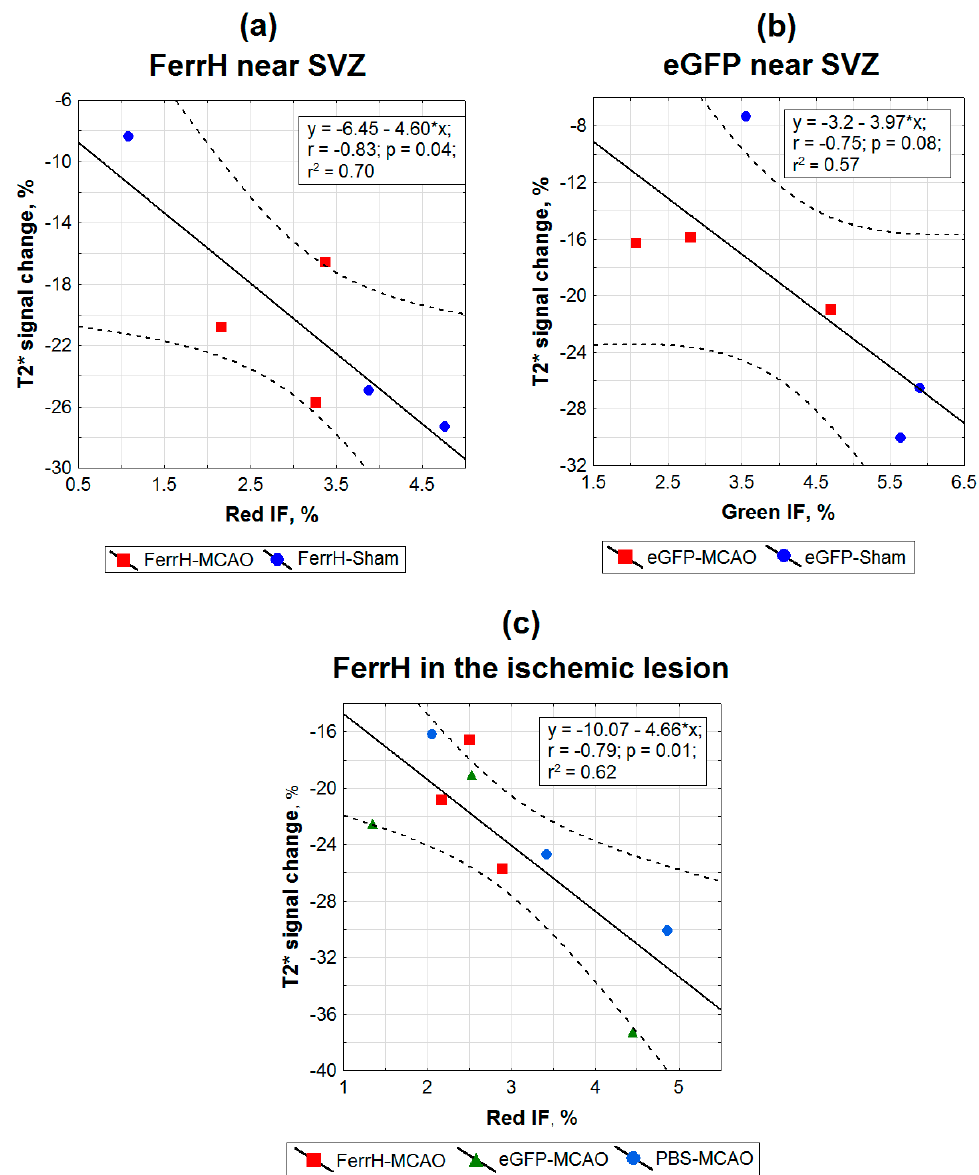
Figure 5. Histological validation of the MRI signal hypointensity areas at day 28 after AAV-pDCX-FerrH, AAV-pDCX-eGFP, or PBS with fluorescent images of eGFP signal, FerrH-, and CD68-stained brain sections. Panels ( a – c ) show linear regression plots of the percentage changes in T2* signal hypointensity relative to the baseline point as in the ischemic lesion relative to the symmetric contralateral anatomical region as a function of ( a ) FerrH IF in the zone near the SVZ, ( b ) eGFP IF in the zone near the SVZ, and ( c ) FerrH IF in the ischemic lesion. Points represent color-coded individual data for the animals from di ff erent groups. Abbreviations: MCAO, middle-cerebral-artery occlusion; AAV, adeno-associated viral backbone; pDCX, doublecortin promoter; FerrH, ferritin heavy chain; eGFP, enhanced green fluorescent protein; PBS, phosphate-bu ff ered saline; SVZ, subventricular zone; red IF, intensity of red channel immunofluorescence in micrographs; green IF, intensity of green channel immunofluorescence in micrographs.